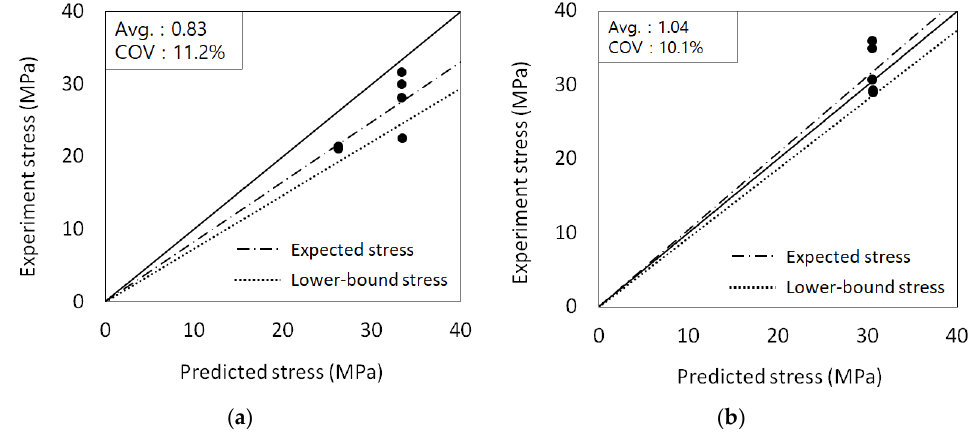
Figure 16. Predicted and test compressive strengths for prisms strengthened on both sides: ( a ) Red clay brick masonry; ( b ) concrete brick masonry.